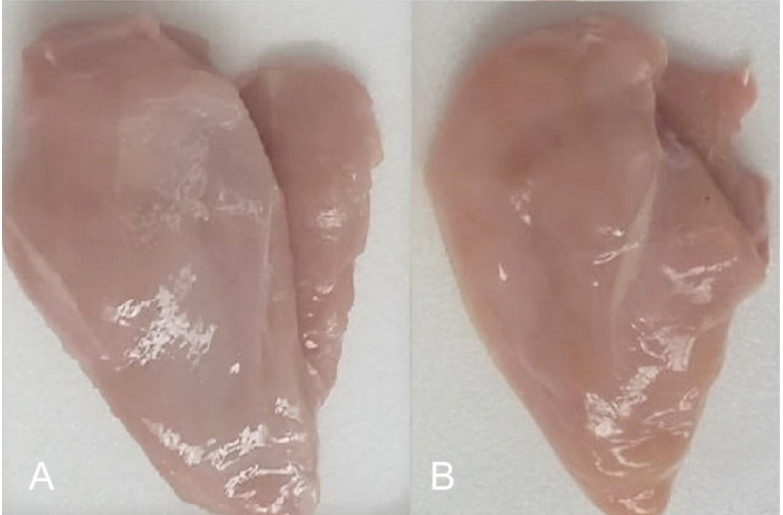
Figure 5. Visual comparison of chicken breast fillets with ( A ) and without ( B ) the EC antimicrobial.